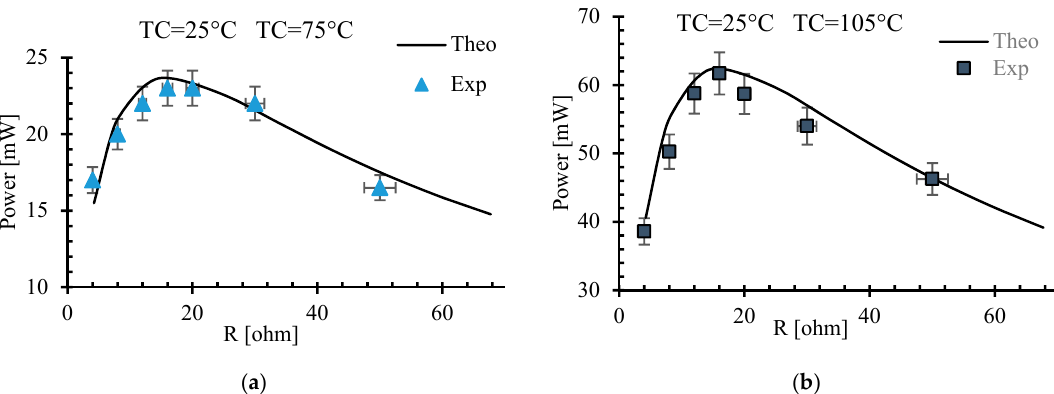
Figure 6. Experimental results and model prediction for module power output. ( a ) Small temperature difference and ( b ) high temperature difference.